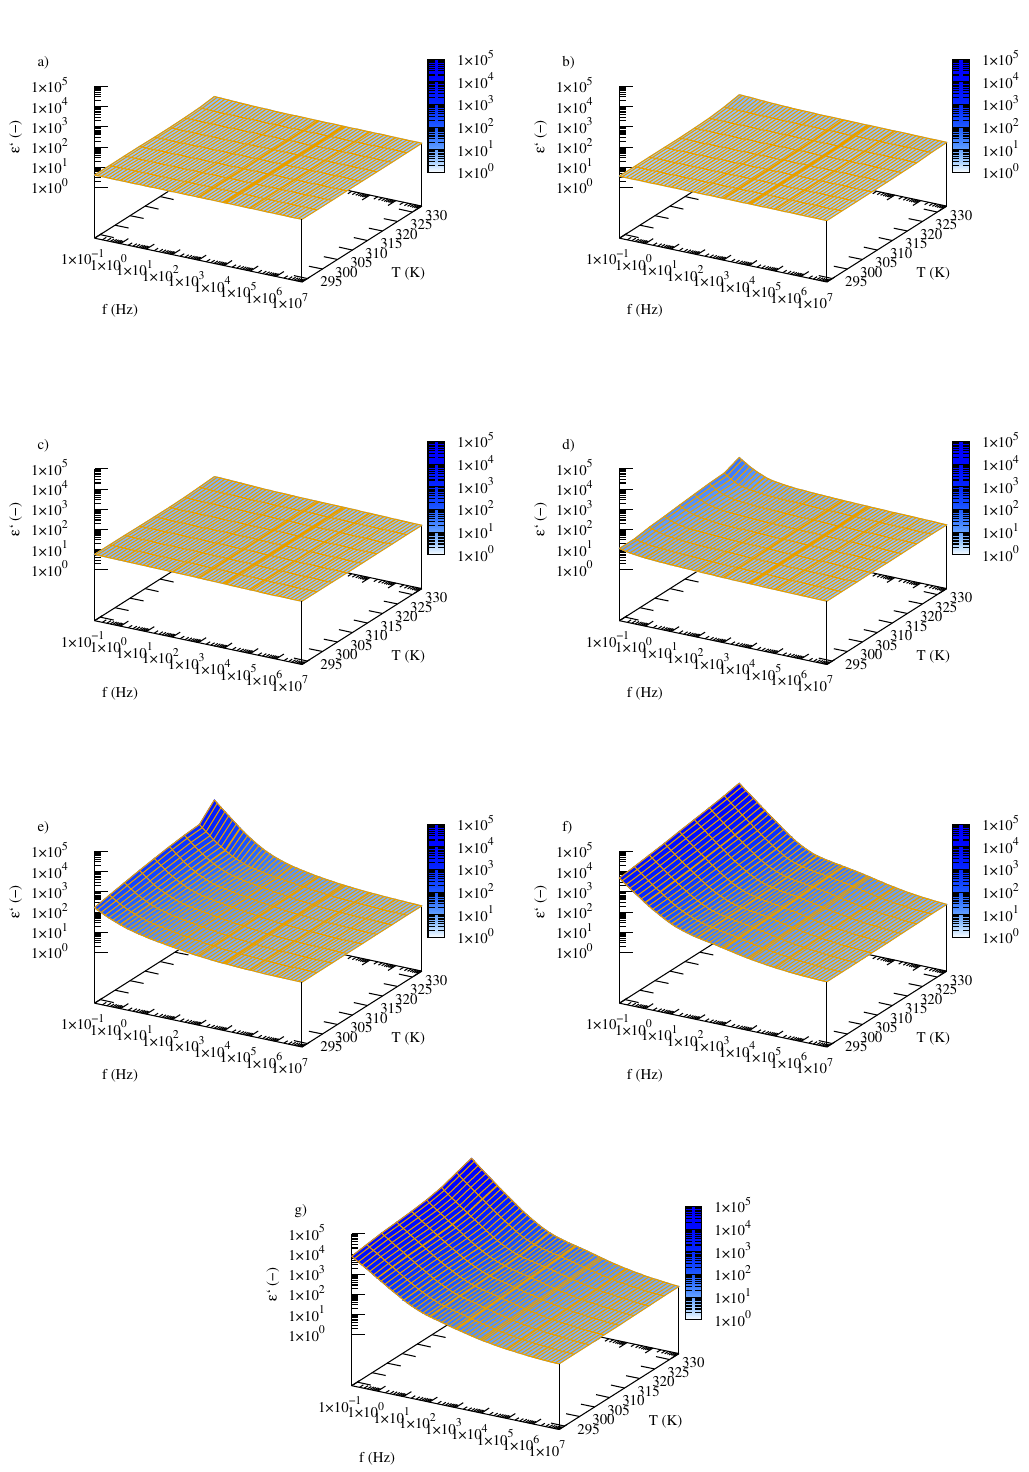
Figure A2. The real part of the permittivity, ε (cid:48) , of silicon-dioxide–lignin polylactide nanocomposites as a function of frequency and temperature for ( a ) unprocessed and unfilled PLA, ( b ) unfilled PLA, ( c ) PLA with FB and GL, ( d ) 0.01 mass fraction, ( e ) 0.05 mass fraction, ( f ) 0.10 mass fraction, and ( g ) 0.15 mass